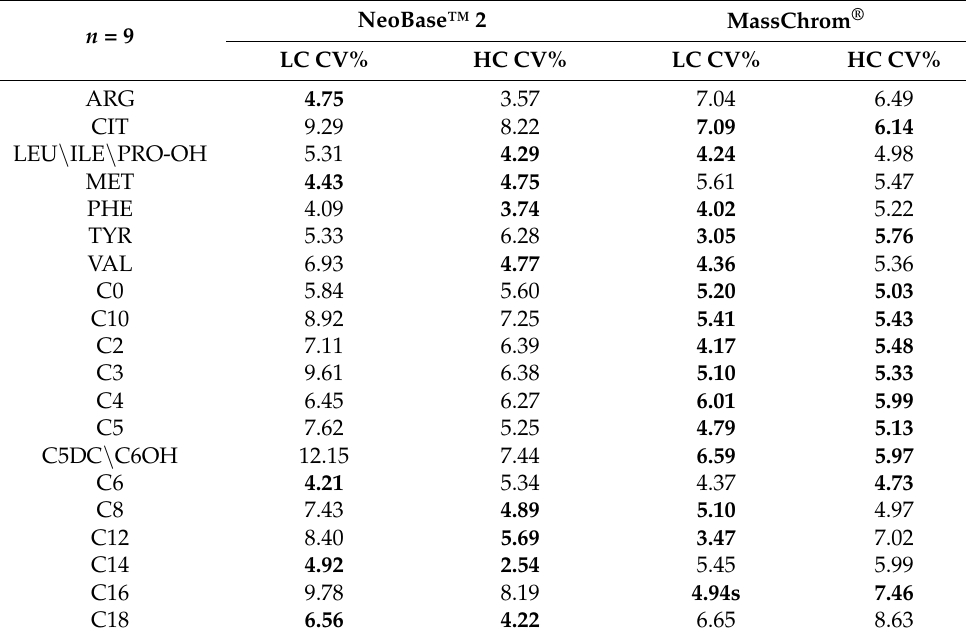
Table 4. Comparison of inter-day precision values from QC levels provided by manufacturers between NeoBase™ 2 and MassChrom ® non-derivatized kits on the RenataDX Screening System. For each analyte, the lower %CV value was highlighted in bold when comparing low and high QCs, respectively. n = 9